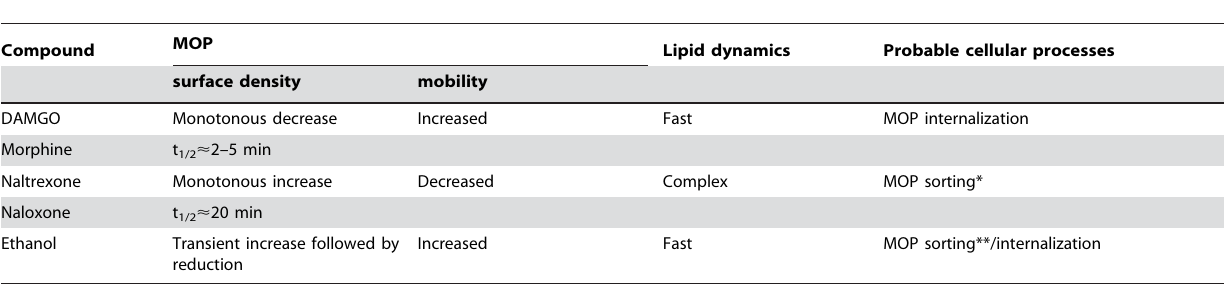
Table 1. A summary of ethanol effects at MOP and plasma membrane lipid dynamics compared to the effects of specific ligands.